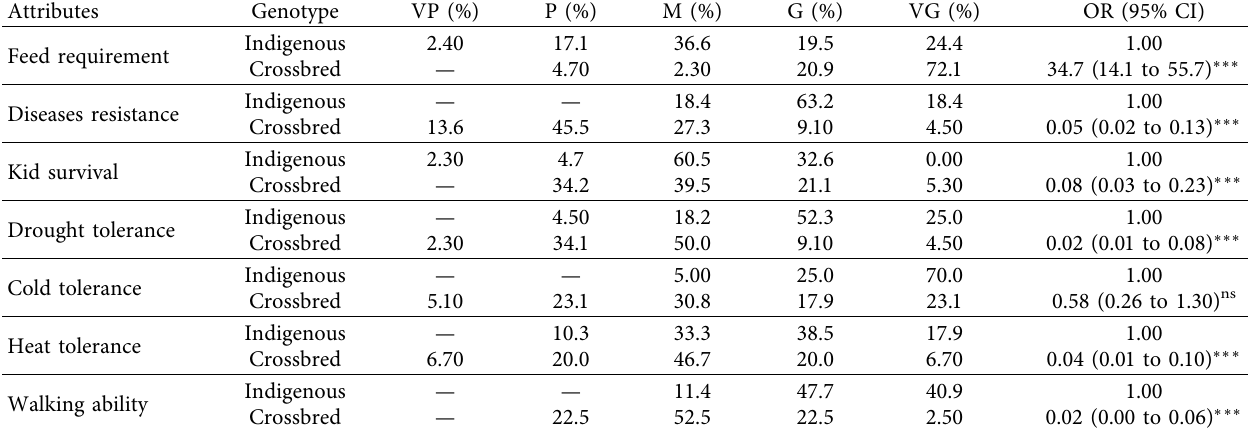
Table 5: Odds ratio estimates of the adaptability attributes (crossbred vs indigenous